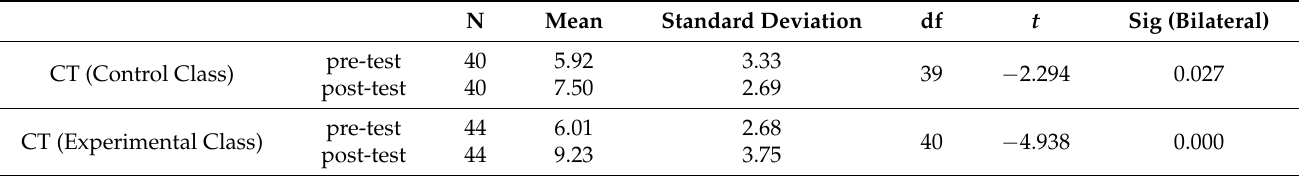
Table 3. Paired sample t -test of students’ CT performances in experimental class and control class.